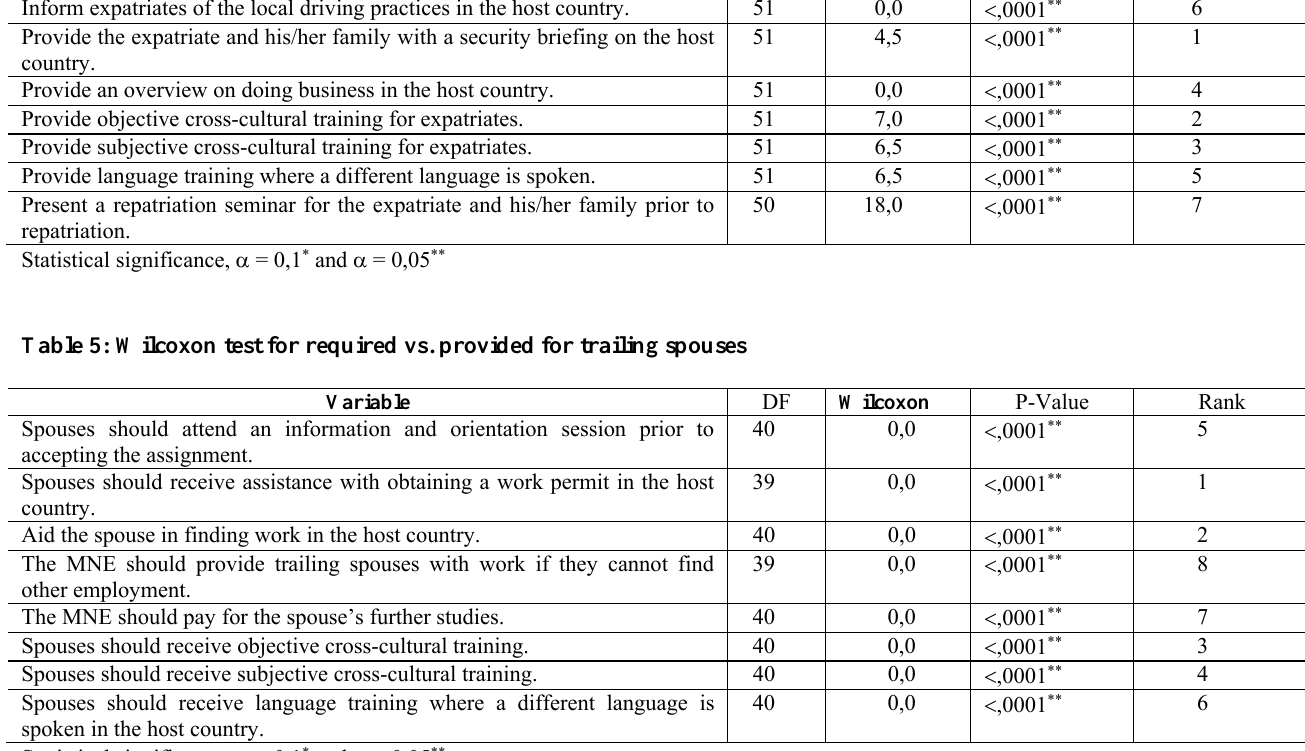
Table 4: Wilcoxon test for training required vs. provided Variable DF Wilcoxon P-Value Rank